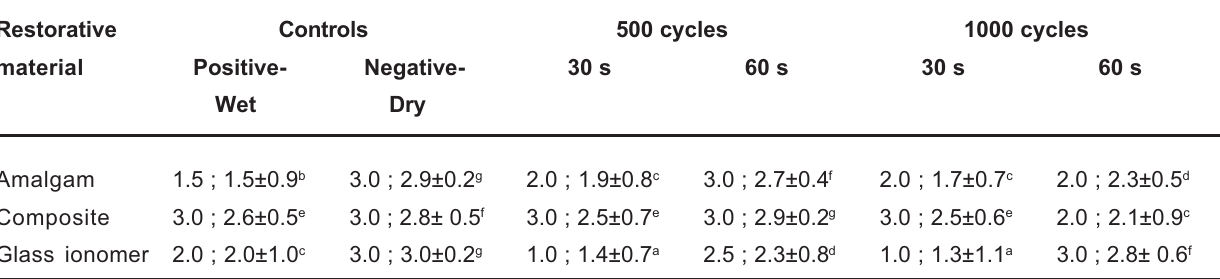
TABLE 2- Microleakage results for dentin Restorative